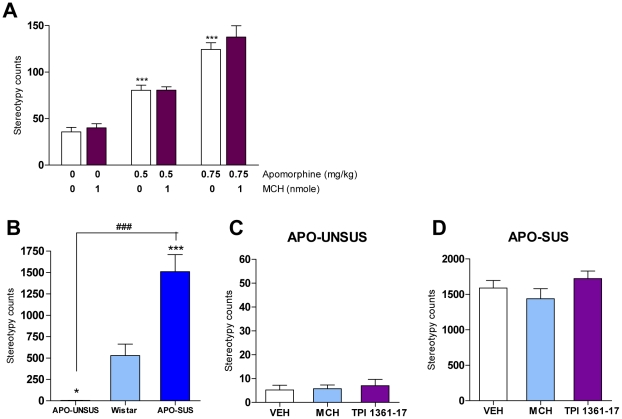
Apomorphine-induced stereotyped behaviors upon MCH injection.A. Effect of MCH (0, 1 nmole) on apomorphine (0, 0.5, 0.75 mg/kg)-induced stereotyped behaviors in mice (***p<0.001 vs. VEH, two-way ANOVA with Bonferroni test; n = 5–10). B. Stereotypy counts in APO-UNSUS, wild type Wistar and APO-SUS rats after apomorphine (1.5 mg/kg) injections (*p<0.05 ***p<0.001 vs Wistar ###
p<0.001 vs APO-UNSUS, one-way ANOVA with bonferroni's posttests; n = 10–15). C. Effect of MCH (10 nmole) and TPI 1361-17 (10 nmole) on apomorphine (1.5 mg/kg)-induced stereotyped behavior in APO-UNSUS rats (n = 10–13). D. Effect of MCH (10 nmole) and TPI 1361-17 (10 nmole) on apomorphine (1.5 mg/kg)-induced stereotyped behavior in APO-SUS rats (n = 11–13). Values (A–D) represent total stereotypy counts ± SEM.